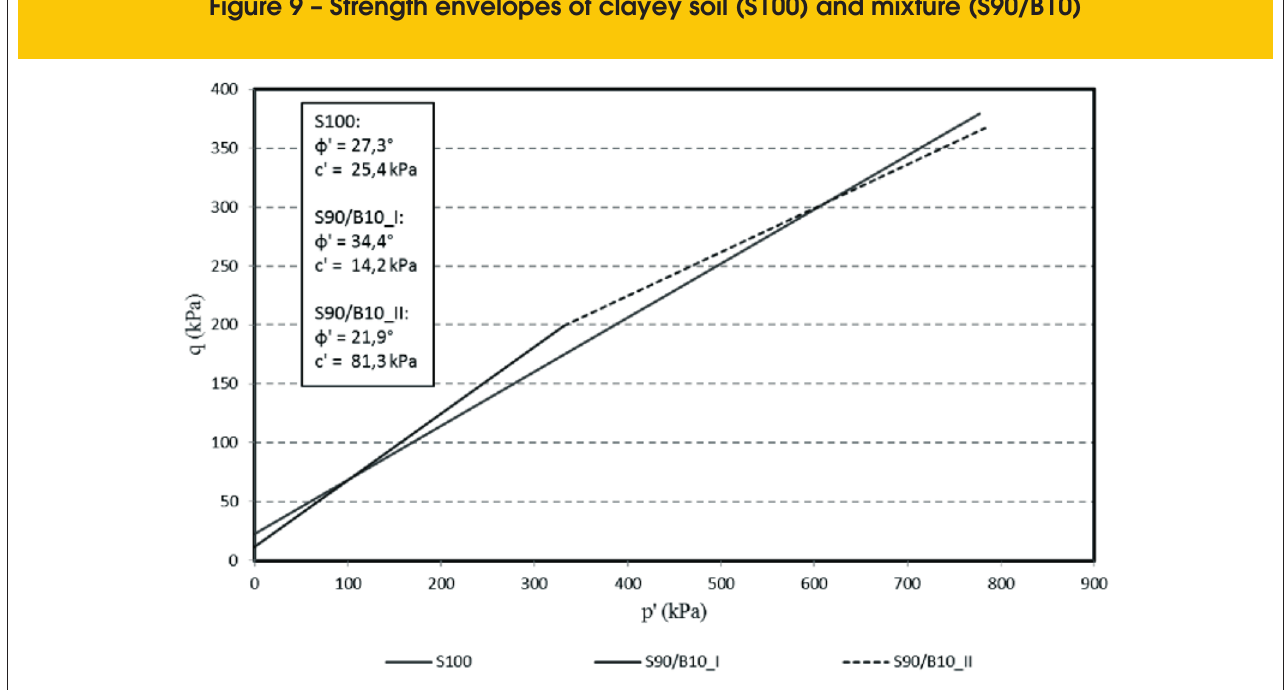
Figure 9 – Strength envelopes of clayey soil (S100) and mixture